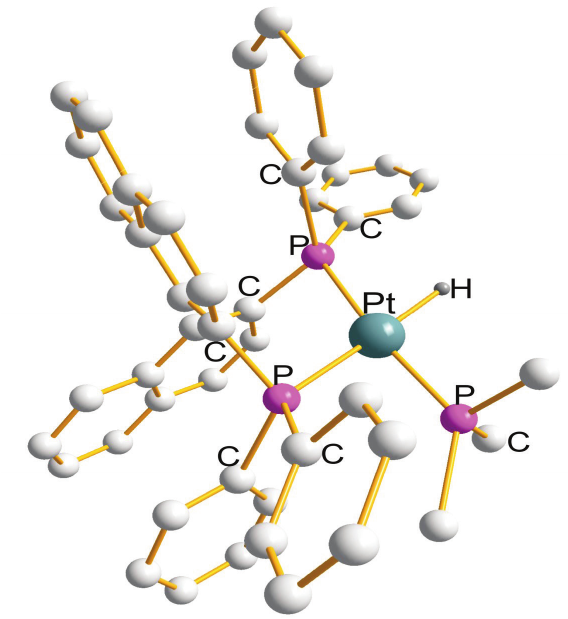
}{P(C H N)(Ph) 2 5 4